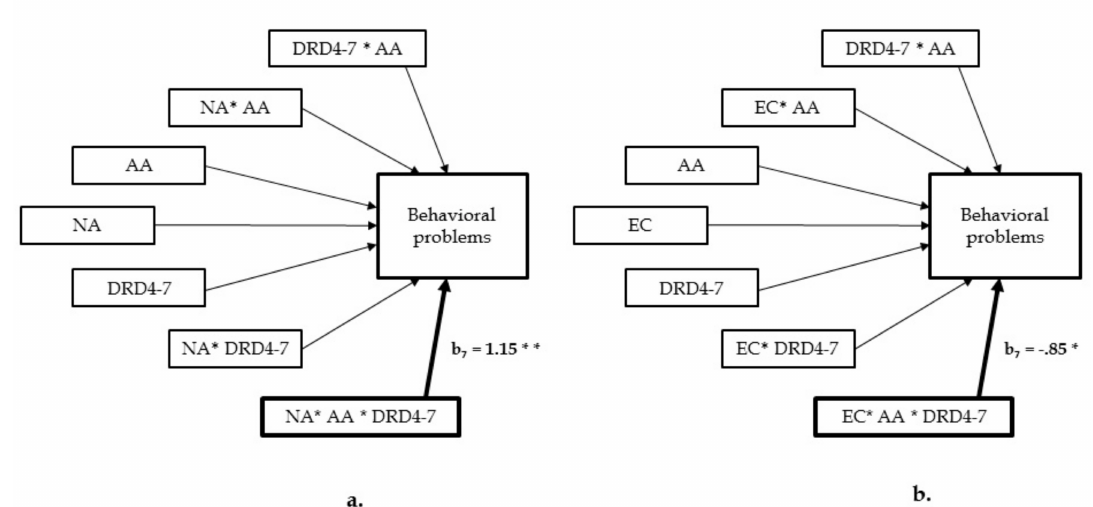
Figure 1. A moderation model with 2 moderators, showing significant effects of 3-way interaction with ( a ) mothers’ temperamental negative affectivity and ( b ) mothers’ temperamental effortful control on the outcome (behavioral problems of children). b = unstandardized coefficient; NA = Negative Affect; EC = Effortful Control; AA = Age at adoption; DRD4-7 = the 7r allele of the dopamine D4 receptor gene. * p < 0.05, ** p <